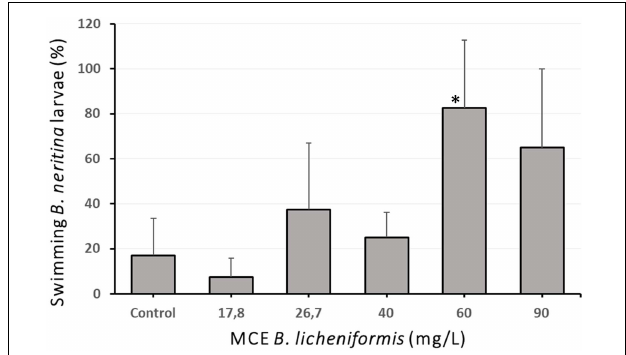
FIGURE 4 | Percentage of swimming and settled larvae of the bryozoan Bugula neritina 24 h after exposure to the methanol cell extract (MCE) of Bacillus licheniformis ( N = 4 × 10). Error bars represent standard deviations of the mean. ∗ indicates significant differences with the control group (Kruskal-Wallis, p = 0.045. Dunn’s post hoc test, p = 0.027).